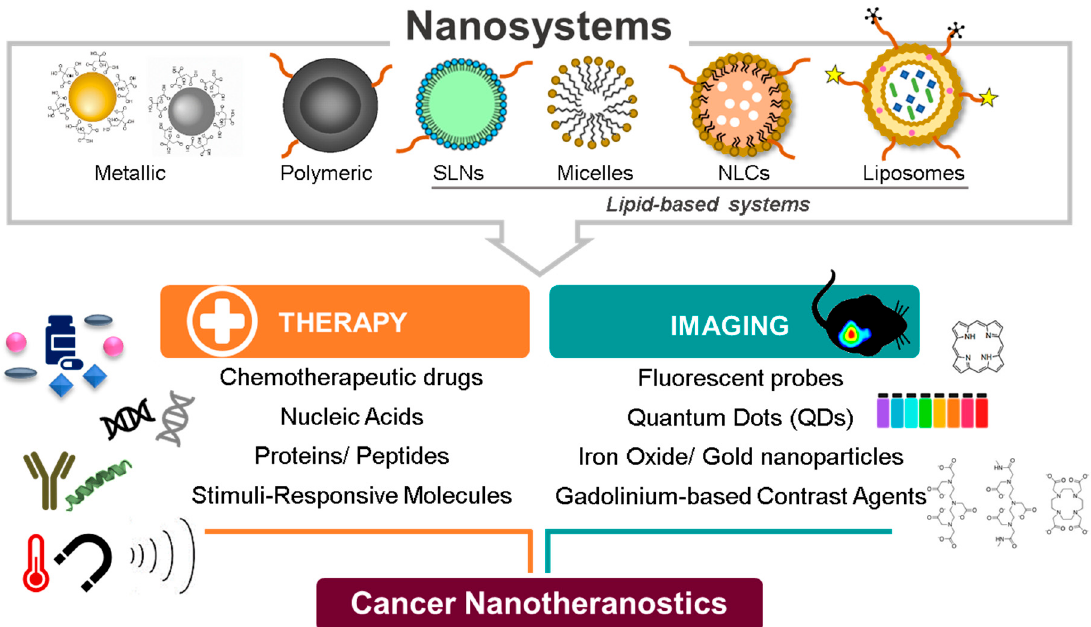
Figure 1. Nanotheranostics: polymeric, metallic, and lipid-based nanosystems for cancer management.